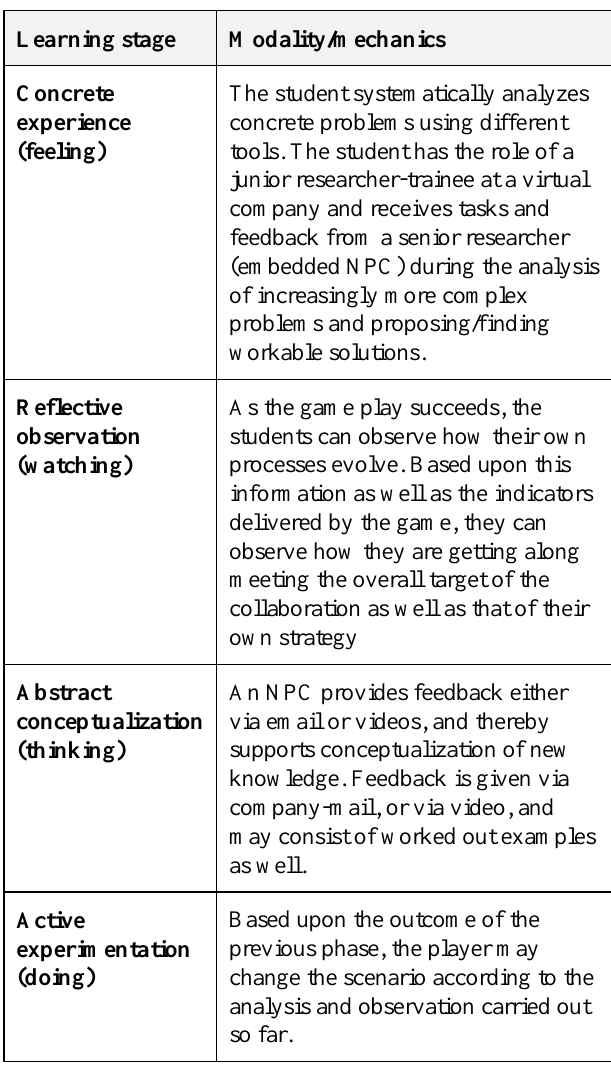
Table 3 : Kolb’s learning cycle the Scheldt